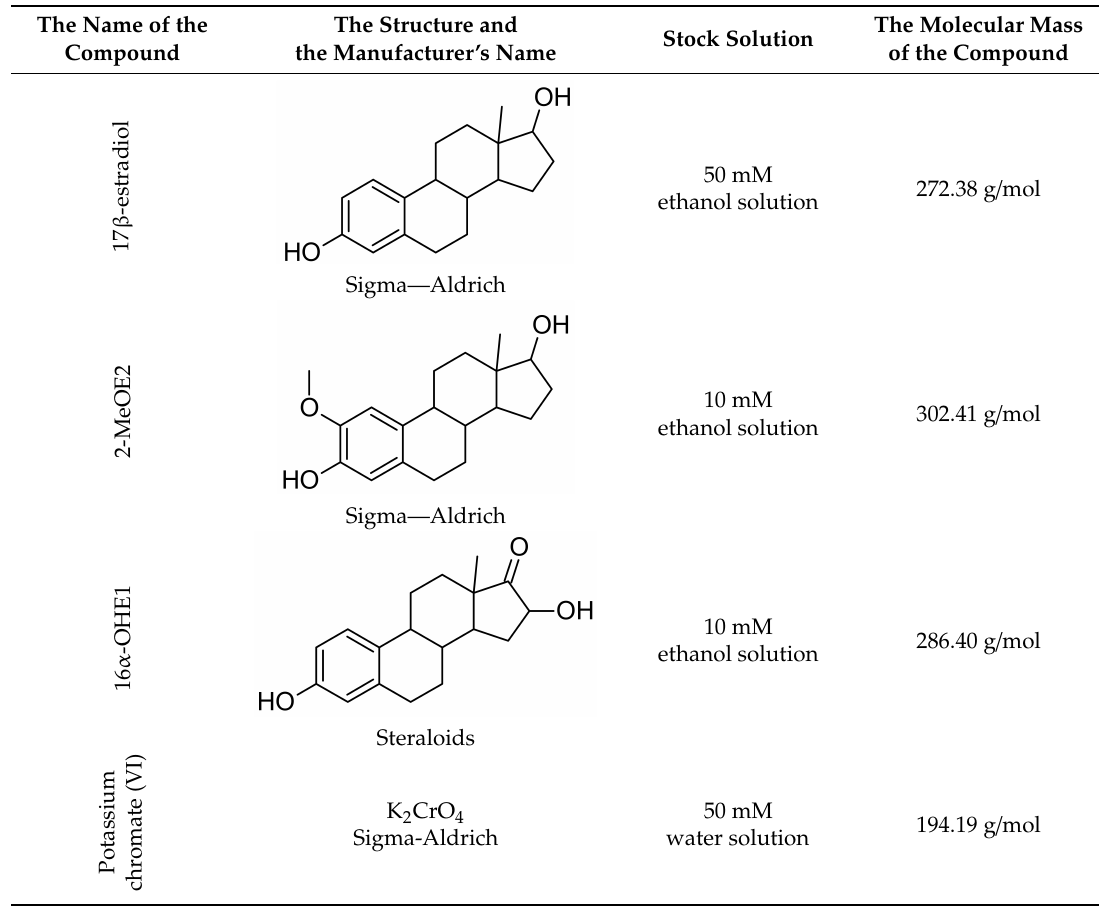
Table 4. The list of tested